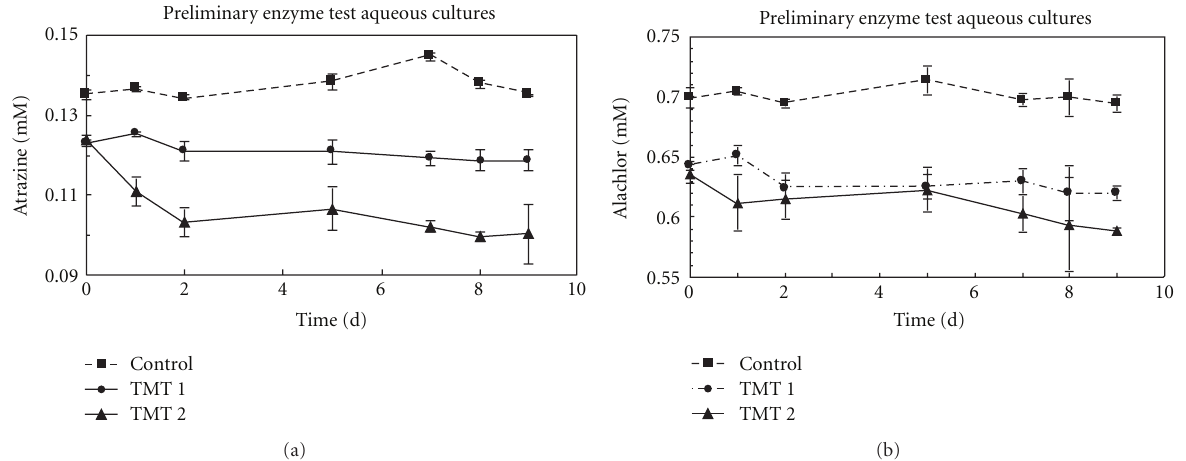
Figure 1: Disappearance of AT and AL from aqueous cultures treated with the EES. Treatment 1 consisted of the addition of the EES only, while Treatment 2 consisted of the addition of the EES and H 2 O 2 . (a) AT degradation among treatments. (b) AL degradation among treatments. Control consisted of DDW and H 2 O 2 .